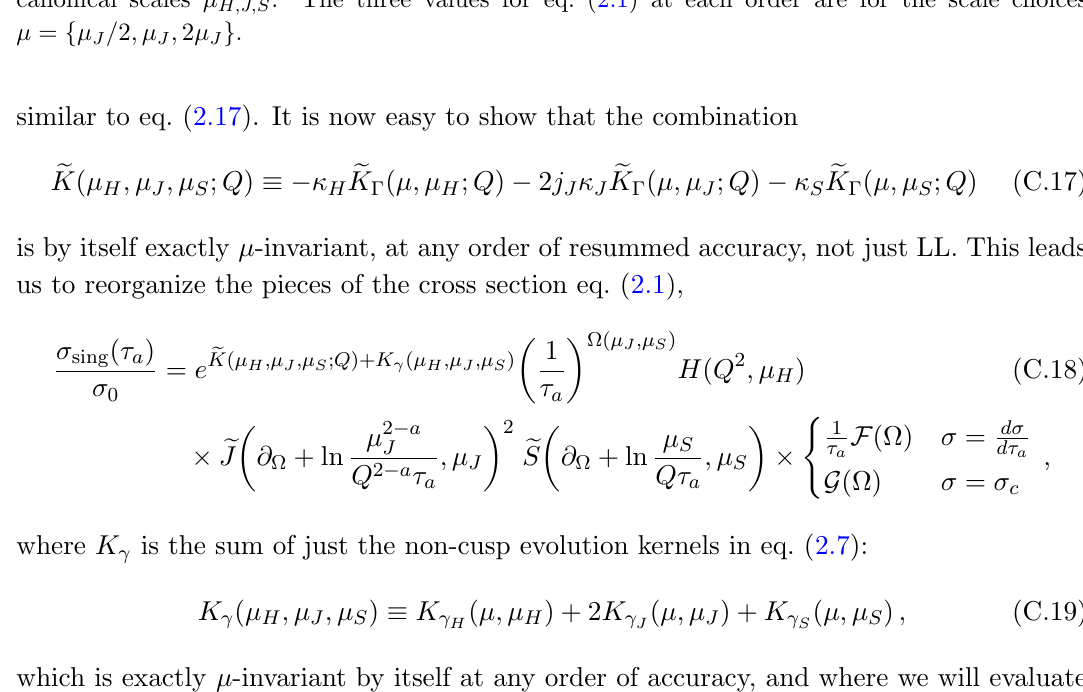
Table 8 . Prediction of (cid:22) -invariant form of resummed perturbative integrated distribution in eq. (C.18) versus standard form eq. (2.1), which has residual (cid:22) -dependence at truncated orders of resummed accuracy. These values are for a = 0, (cid:28) a = 0 : 1, Q = m Z , (cid:11) s ( m Z ) = 0 : 11,